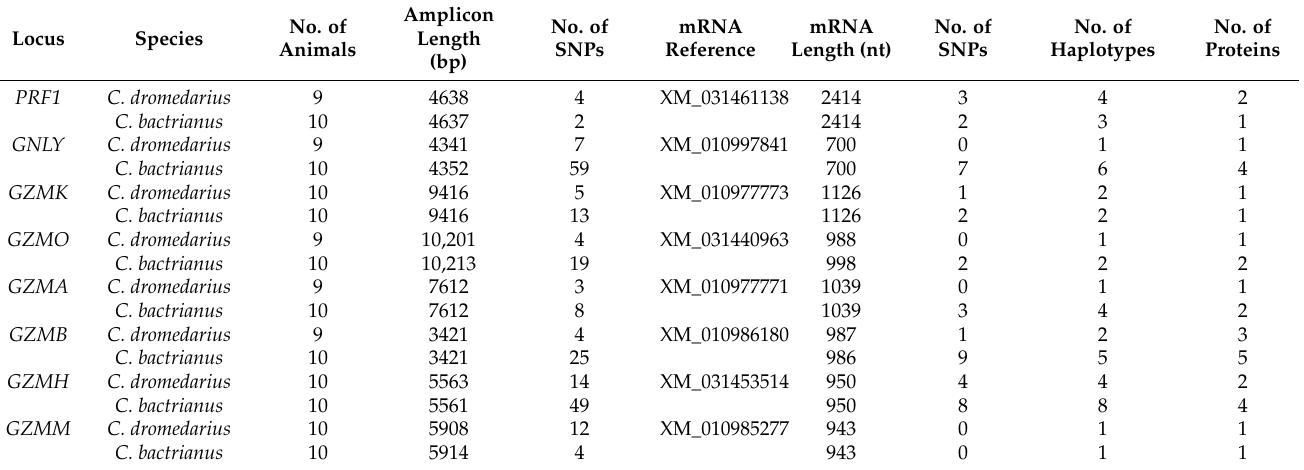
AA positions from proteins of camels and AA change in the S3 pocket distinguished alpaca from all camel sequences. Table 1. Genetic polymorphisms of cytotoxic granule proteins in dromedary and Bactrian camels. No. of Locus Species